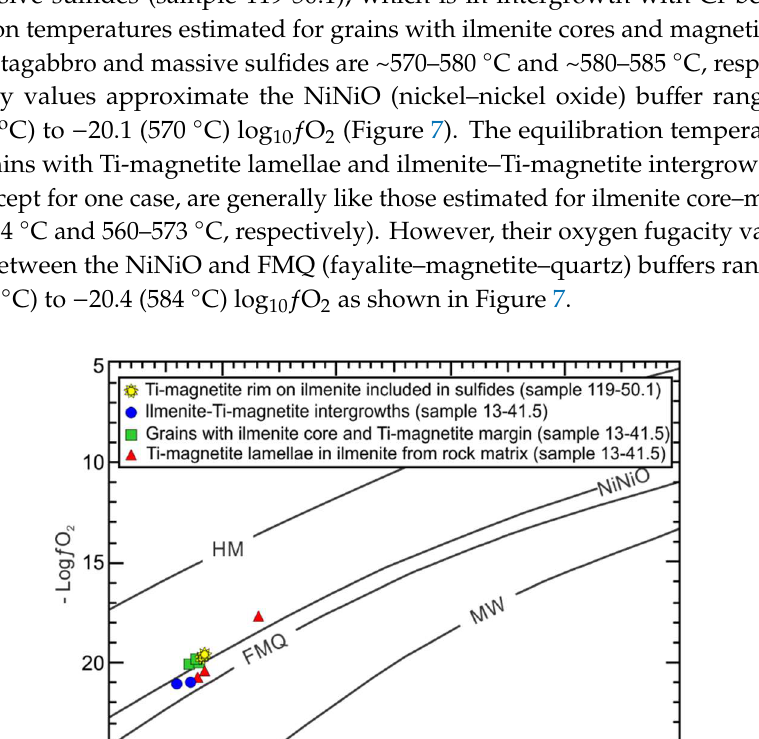
Figure 6. Diagrams showing MgO ( A ) and MnO ( B ) contents of core vs. rim for ilmenite from the metamorphosed mafic-ultramafic rocks of the Sedova Zaimka intrusion. Data from Table S1.